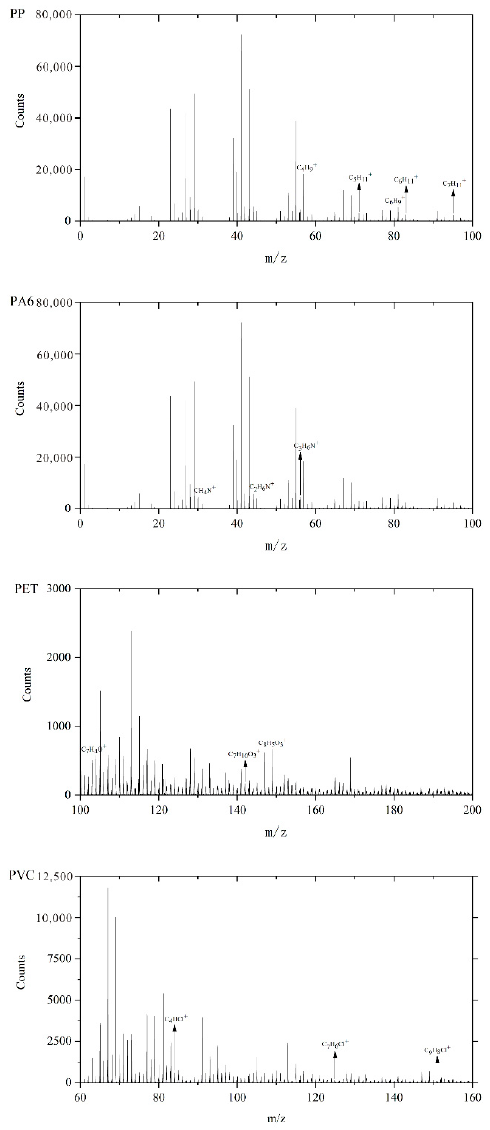
Figure 1. Positive ion spectra obtained XA1.